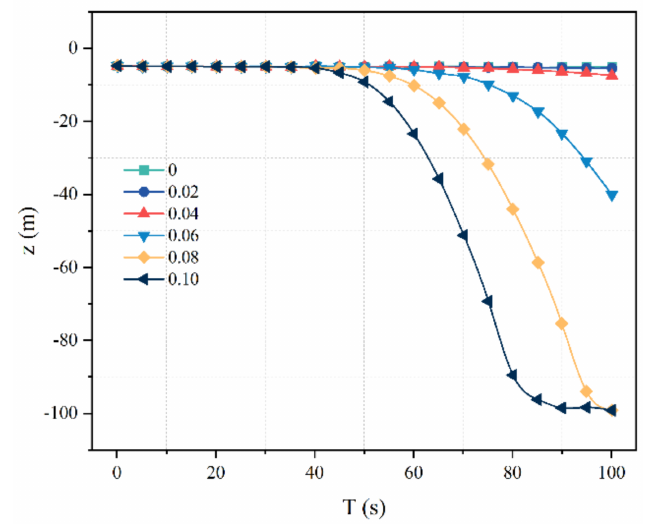
Figure 3. Navigation depth under different Munk moment coefficients.